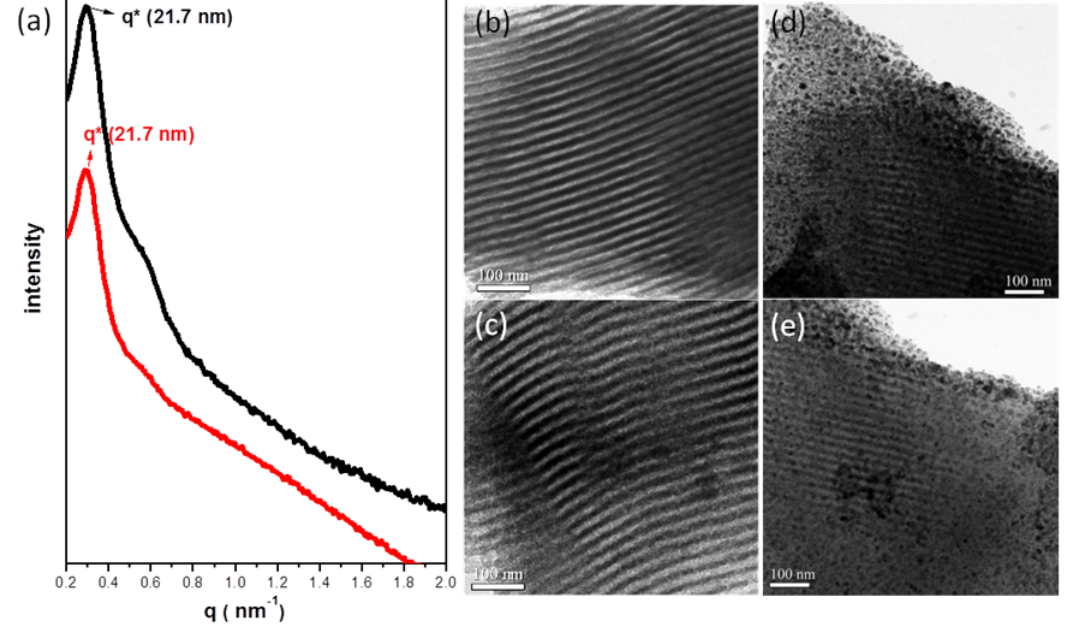
Figure 4. ( a ) SAXS patterns of the hexagonal cylindrical mesoporous carbon and the Pd/cylindrical silica; ( b – e ) TEM images of ( b , c ) the hexagonal cylindrical mesoporous carbon and ( d , e ) the Pd/cylindrical carbon.